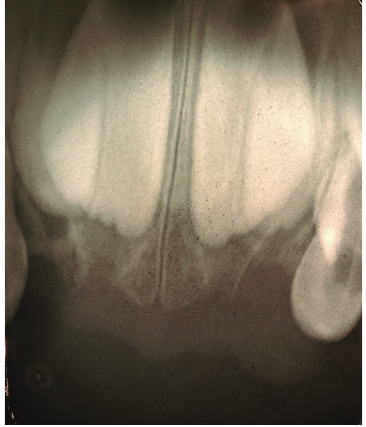
Figure 2: Intraoral periapical radiograph, showing superficial ero- sion of the alveolar bone.